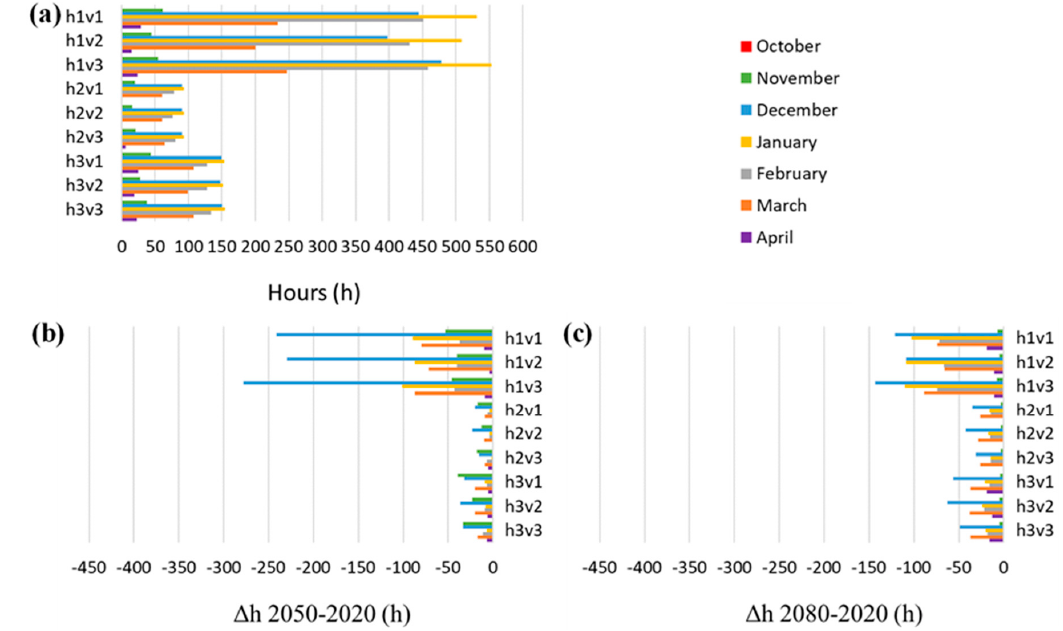
Figure 5. Monthly hours of operation of the heating system: ( a ) in the current climate, and differences Δ h in the year ( b ) 2050 and ( c ) 2080.